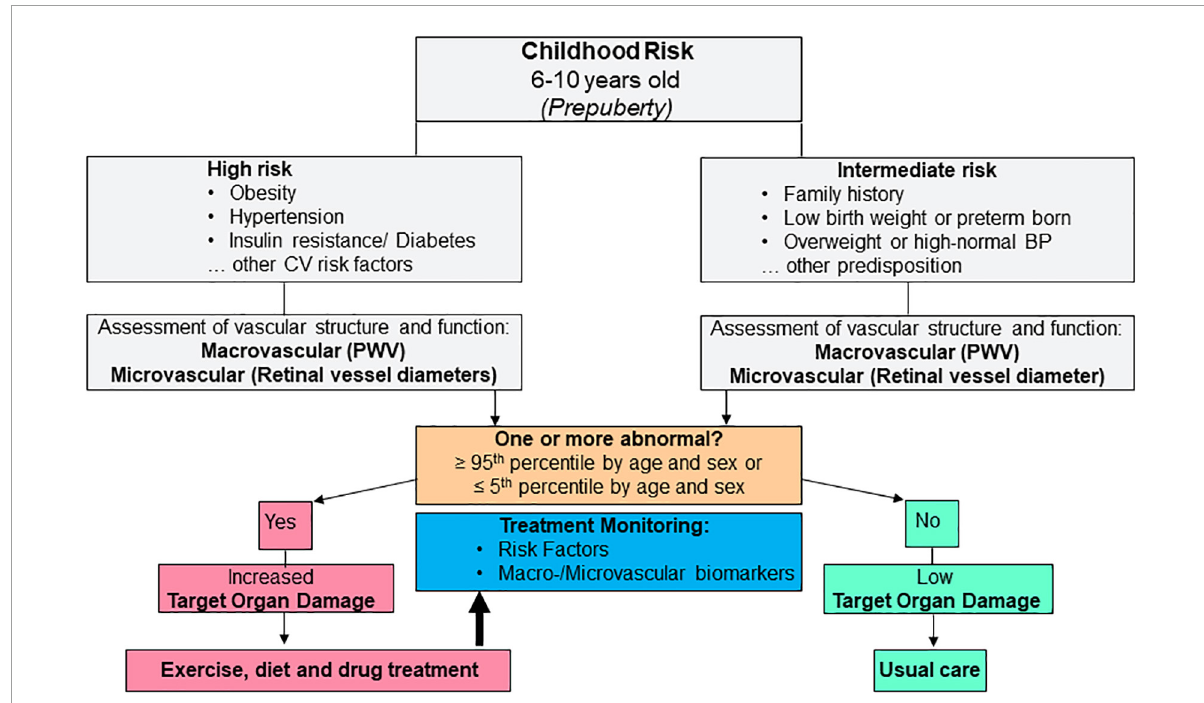
FIGURE2 Example for potential future clinical implementation of vascular biomarkers as a means for cardiovascular risk stratification and treatment monitoring during childhood. CV,